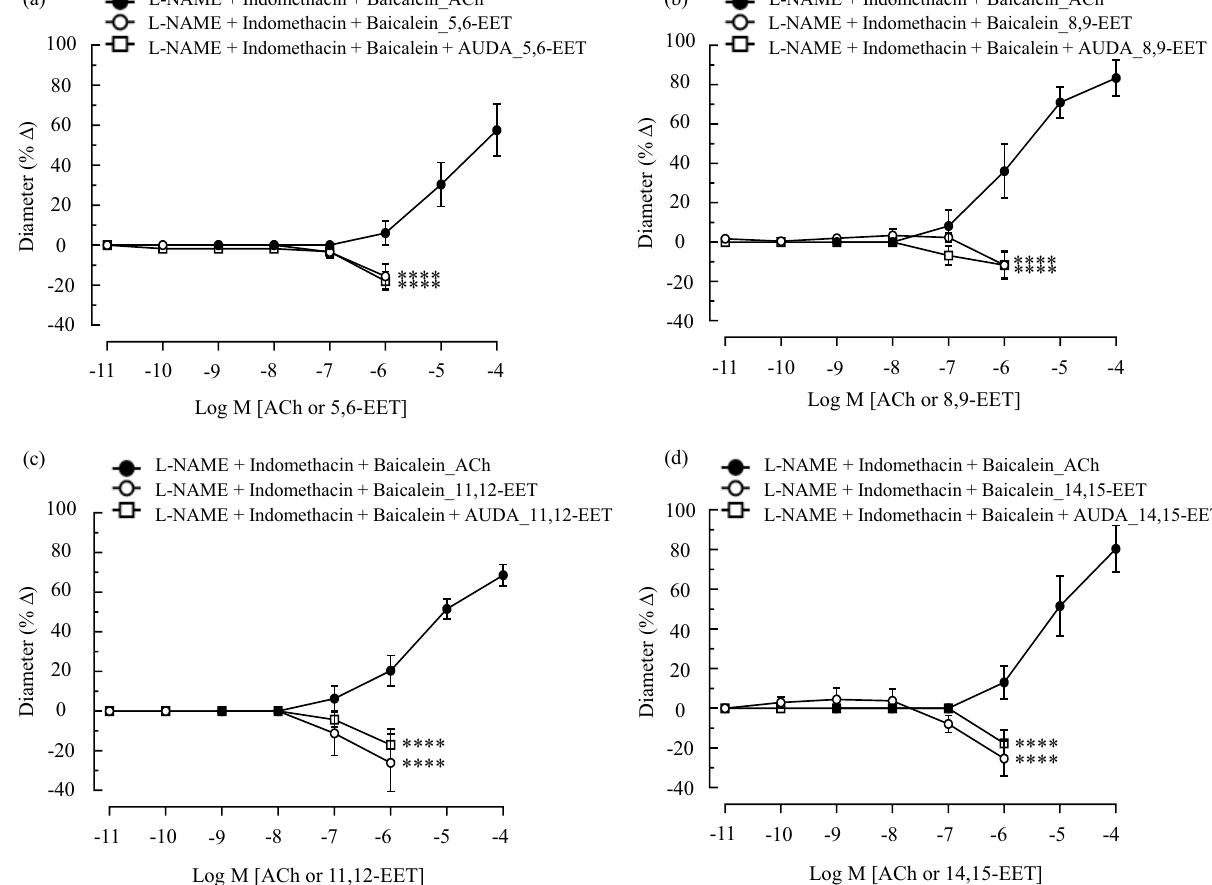
Figure 5. Exogenous administration of synthetic EET regioisomers evoked vasoconstriction of the ophthalmic artery. Cumulative application (0.01 nmol/L–1 µmol/L) of ( a ) 5, 6- ( b ) 8, 9- ( c ) 11, 12- and ( d ) 14, 15-EET in the absence and presence of AUDA (100 nmol/L) exhibited significant concentration-dependent vasoconstriction of the vessels. Values are expressed as mean ± s.e.m, n = 6 per group. Absence of error bar indicates that the s.e.m was less than the size of the symbol. **** P < 0.0001, vs. L-NAME + indomethacin + baicalein_ACh at respective